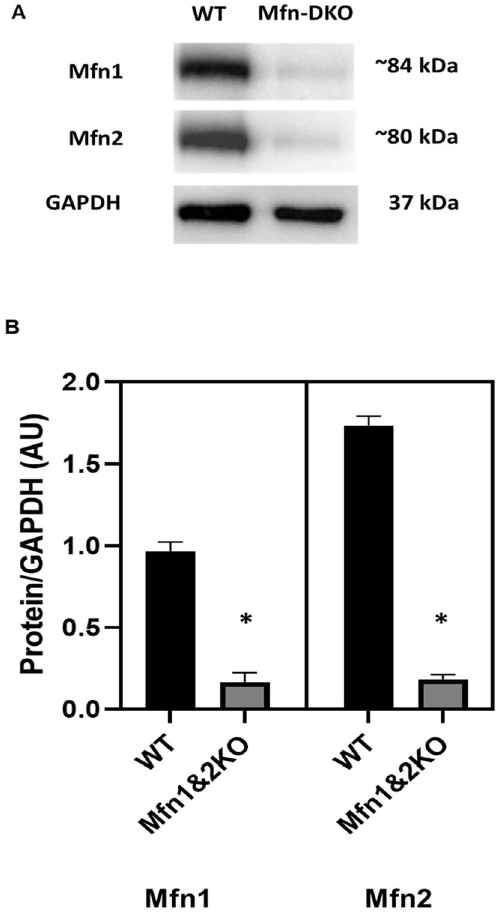
Figure 1. Mfn1 and Mfn2 expression in the Mfn-DKO hearts. ( A ) Representative Western blot image (cropped) of Mfn1 and Mfn2 expression in the WT control versus Mfn-DKO hearts. Original gel images